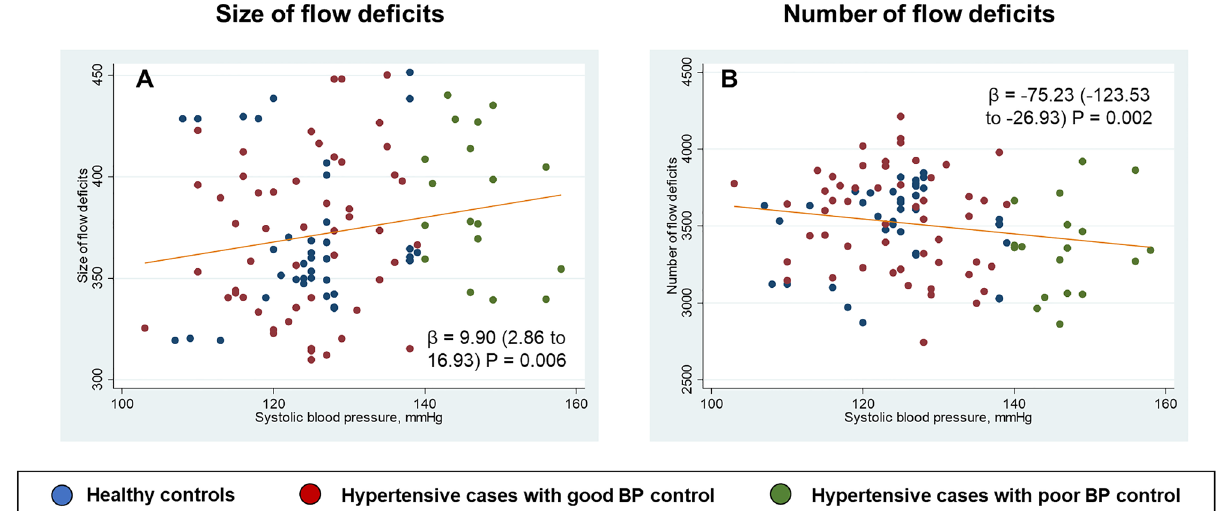
Figure 4. Scatterplots showing ( A ) positive correlation of size of flow deficits with systolic blood pressure and ( B ) negative correlation of number of flow deficits with systolic blood pressure in participants without hypertension (healthy controls; green), hypertensives with good blood pressure control (red) and hypertensives with poor blood pressure control